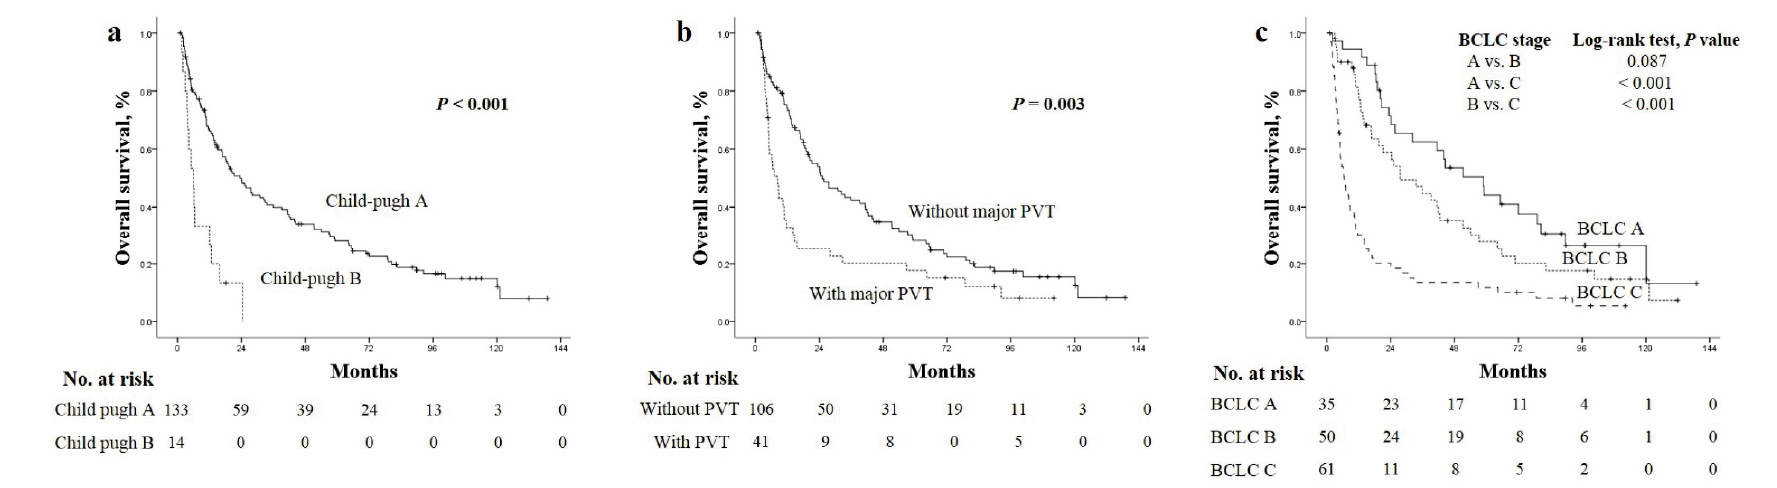
Figure 3. The Kaplan–Meier curves of overall survival according to ( a ) Child–Pugh class, ( b ) presence of major PVT and ( c ) BCLC stages.